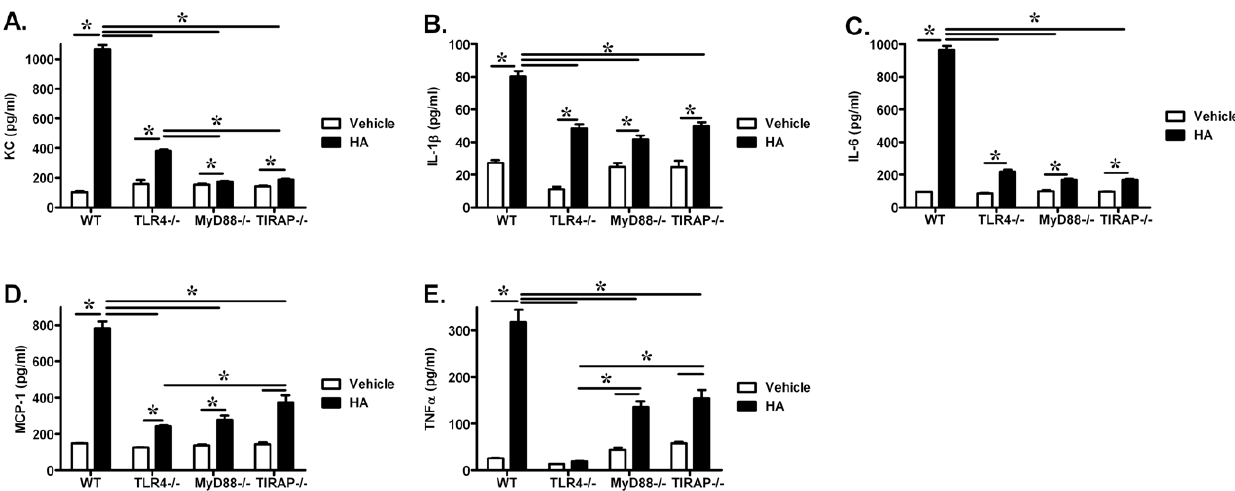
Figure 8. Direct challenge to hyaluronan fragments increased the level of pro-inflammatory factors in alveolar lavage fluid in a manner partially dependent on TLR4, MyD88, and TIRAP. The level of ( A ) KC, ( B ) IL-1 b , ( C ) IL-6, ( D ) MCP-1 and ( E ) TNF a in BALF from vehicle or HA-challenged WT, TLR4 2 / 2 , MyD88 2 / 2 and TIRAP 2 / 2 mice were measured by luminex beads (*p , 0.05, vs. FA exposed group; # : p , 0.05, vs. O 3 -exposed group comparisons between strains; N=4 per group).